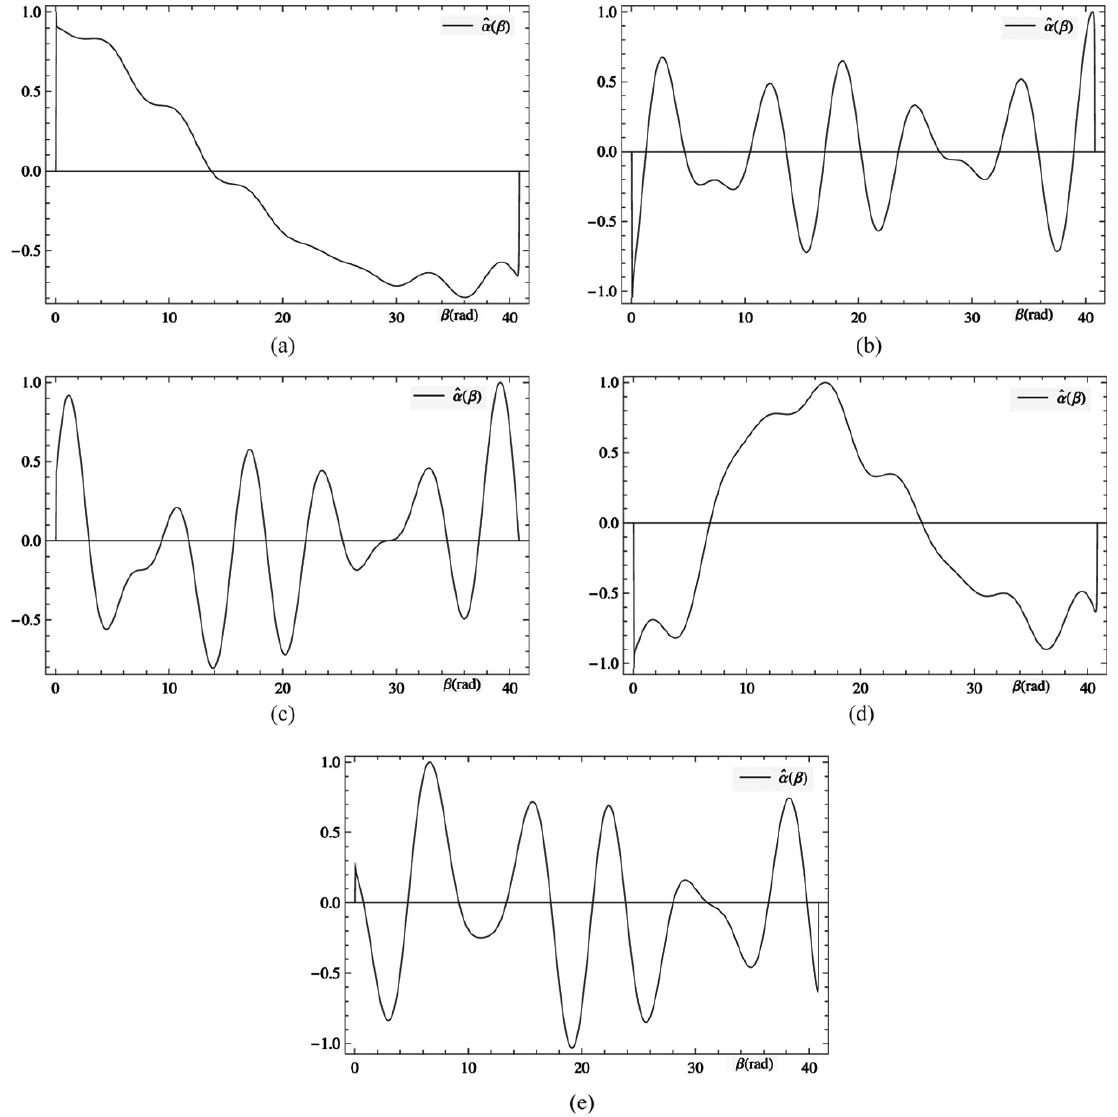
Fig. 4. Normal mode shapes of the generalized warping coordinate: (a) First mode (53.43 Hz) (b) Second mode (74.77 Hz) (c) Third mode (75.17 Hz) (d) Fourth mode (102.48 Hz) (e) Fifth mode (111.39 Hz). obtained from ANSYS. To analyze these springs using the fi nite element method (FEM), we partition them into 6000 three-dimensional solid elements (Solid45), and the total number of nodal points is 10217. The fi rst fi ve